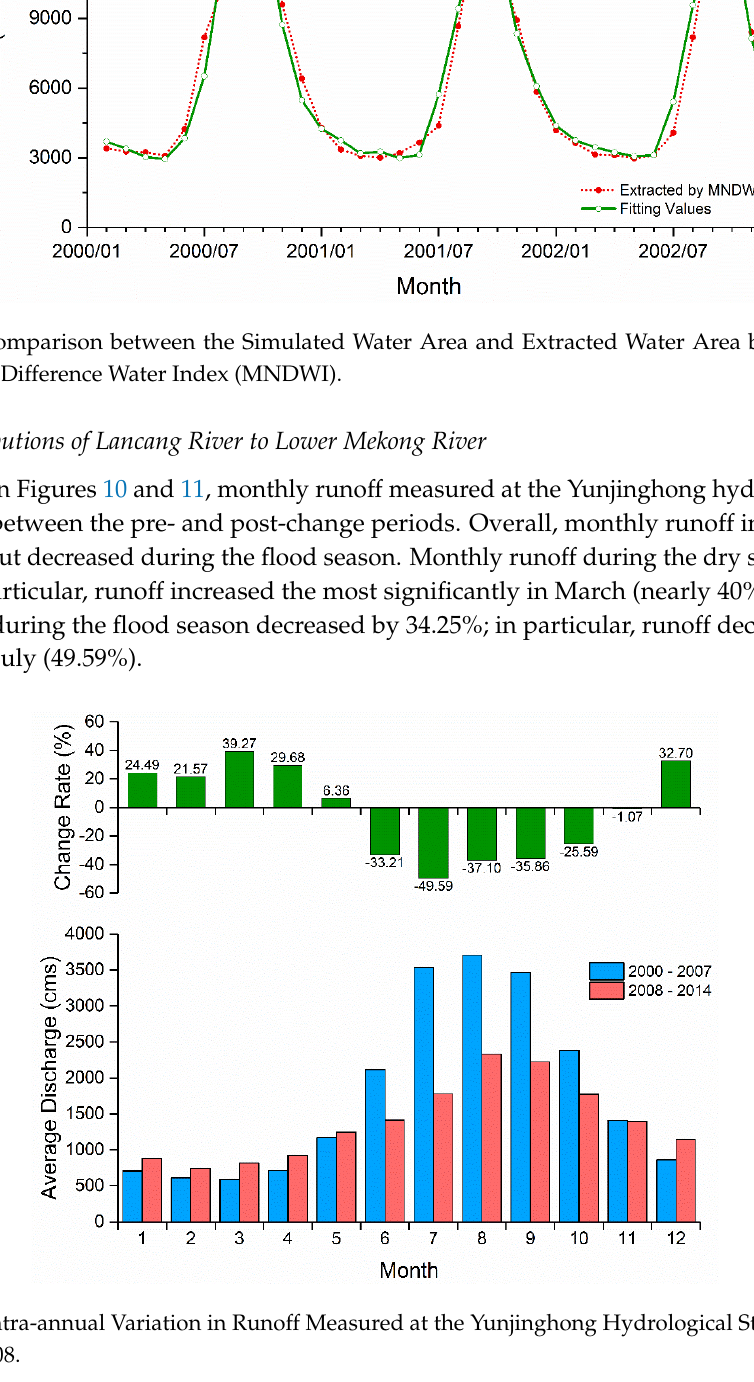
Figure 11. Variation in Runoff during the Flood and Dry Seasons Measured at the Yunjinghong Hydrological Station before and after 2008. Figures 12 and 13 show the ratio of the average monthly runoff measured at the Yunjinghong hydrological station to that measured at the Stung Treng hydrological station during the flood and dry seasons. Overall, the ratio was relatively high (19.87%) during the dry season, especially in April (almost 30%). The ratio was 8.85% on average during the flood season, and it reached as high as 26.19% in May and as low as 7.05% in September. In accordance with the above results, the contribution of outbound flow from China after 2008 to variations in monthly runoff of the lower Mekong River were calculated (Figure 14). Overall, after 2008, changes in the upstream flow (Lancang River) contributed to the increase in runoff of the lower